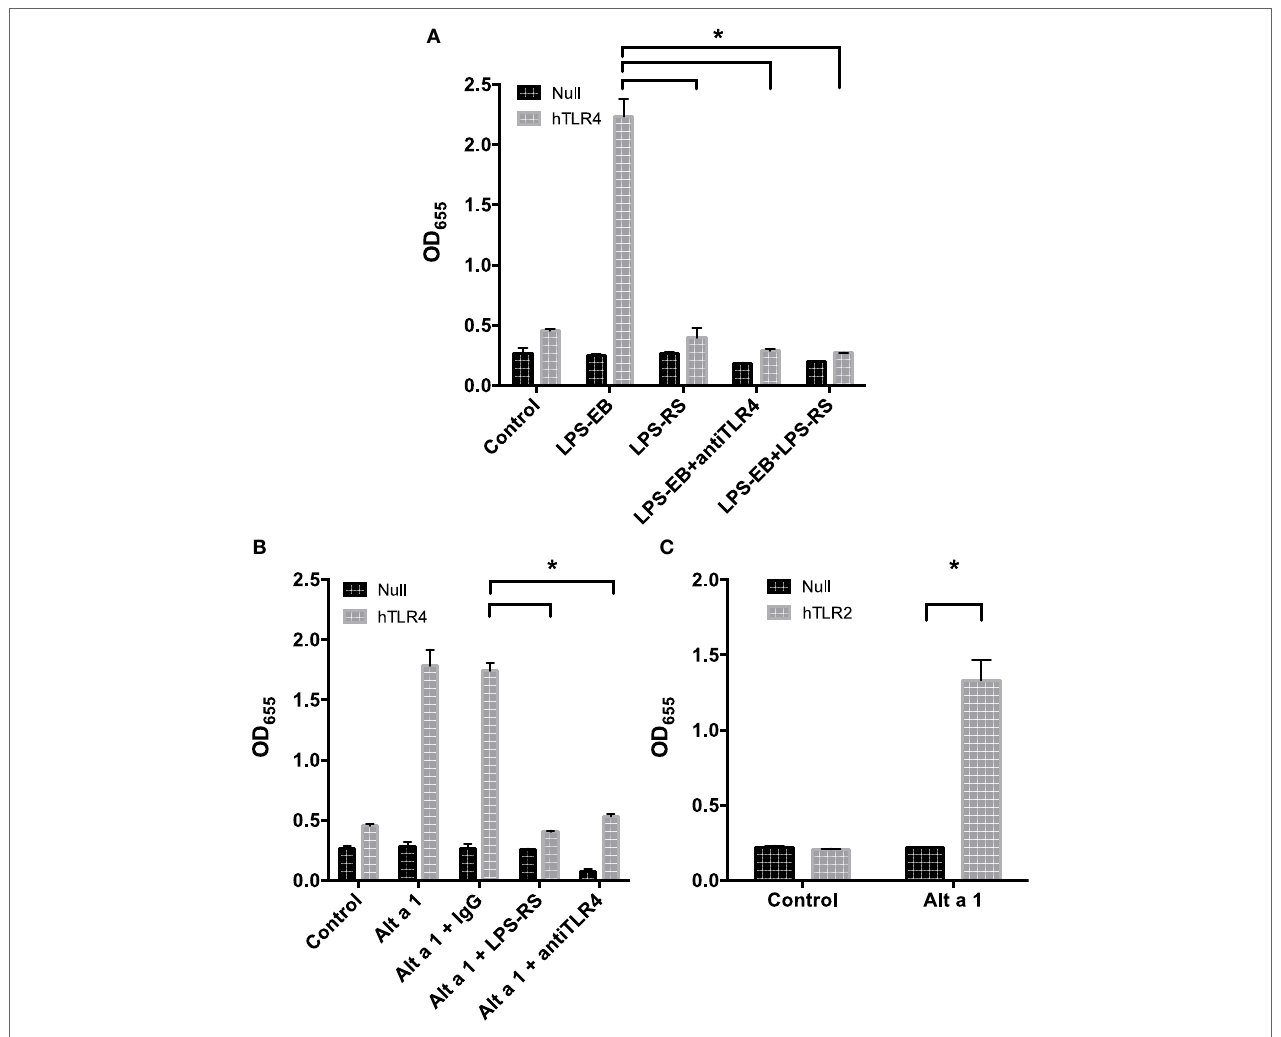
FigUre 6 | Alt a 1 activates toll-like receptor (TLR)2/4-dependent NF- κ B signaling in engineered human embryonic kidney (HEK) cells. 2.5 × 10 4 HEK-Blue hTLR4 (a,B) , HEK-Blue hTLR2 (c) , and HEK-Blue null cells (a–c) were plated in 96-well plates in 200 µL DMEM + 1% Pen/Strep/10% FBS. After 16 h at 37°C/5% CO 2 , the media was removed from the cells. Cells were then starved for 2 h in DMEM + 1% Pen/Strep. (a) Cells were pretreated with 5 ng/mL ultrapure LPS-RS, 10 µg/mL anti-hTLR4-IgG, or 10 µg/mL mouse IgG 1 control for an hour. Then cells were treated with 5 ng/mL ultrapure LPS-EB. Cells incubated with treatments in the incubator for 24 h. Afterward 20 µL of the cell supernatant was added to 180 µL QUANTI-Blue reagent. After incubation for 3 h at 37°C, the plate was read at 655 nM room temperature. Data are represented as mean (SD). After testing for homogeneity of variances, Tukey’s HSD was performed and adjusted (if applicable) (* p < 0.001). Comparisons shown are against LPS-EB (* p < 0.001). (B) Cells were pretreated with 5 ng/mL ultrapure LPS-RS, 10 µg/mL anti-hTLR4-IgG, or 10 µg/mL mouse IgG 1 control for an hour. Then cells were treated with 1 µg rAlt a 1. Cells incubated with treatments in the incubator for 24 h. Afterward, 20 µL of the cell supernatant was added to 180 µL QUANTI-Blue reagent. After incubation for 3 h at 37°C, the plate was read at 655 nM room temperature. Data are represented as mean (SD). After testing for homogeneity of variances, Tukey’s HSD was performed and adjusted (if applicable) (* p < 0.001). Comparisons shown are against Alt a 1 + IgG (* p < 0.001). (c) Cells were treated with 1 µg rAlt a 1. Data are represented as mean (SD). After testing for homogeneity of variances, Tukey’s HSD was performed and adjusted (if applicable) (* p < 0.001). Comparisons shown are against (a) LPS-EB, (B) Alt a 1 alone or Alt a 1 + IgG,